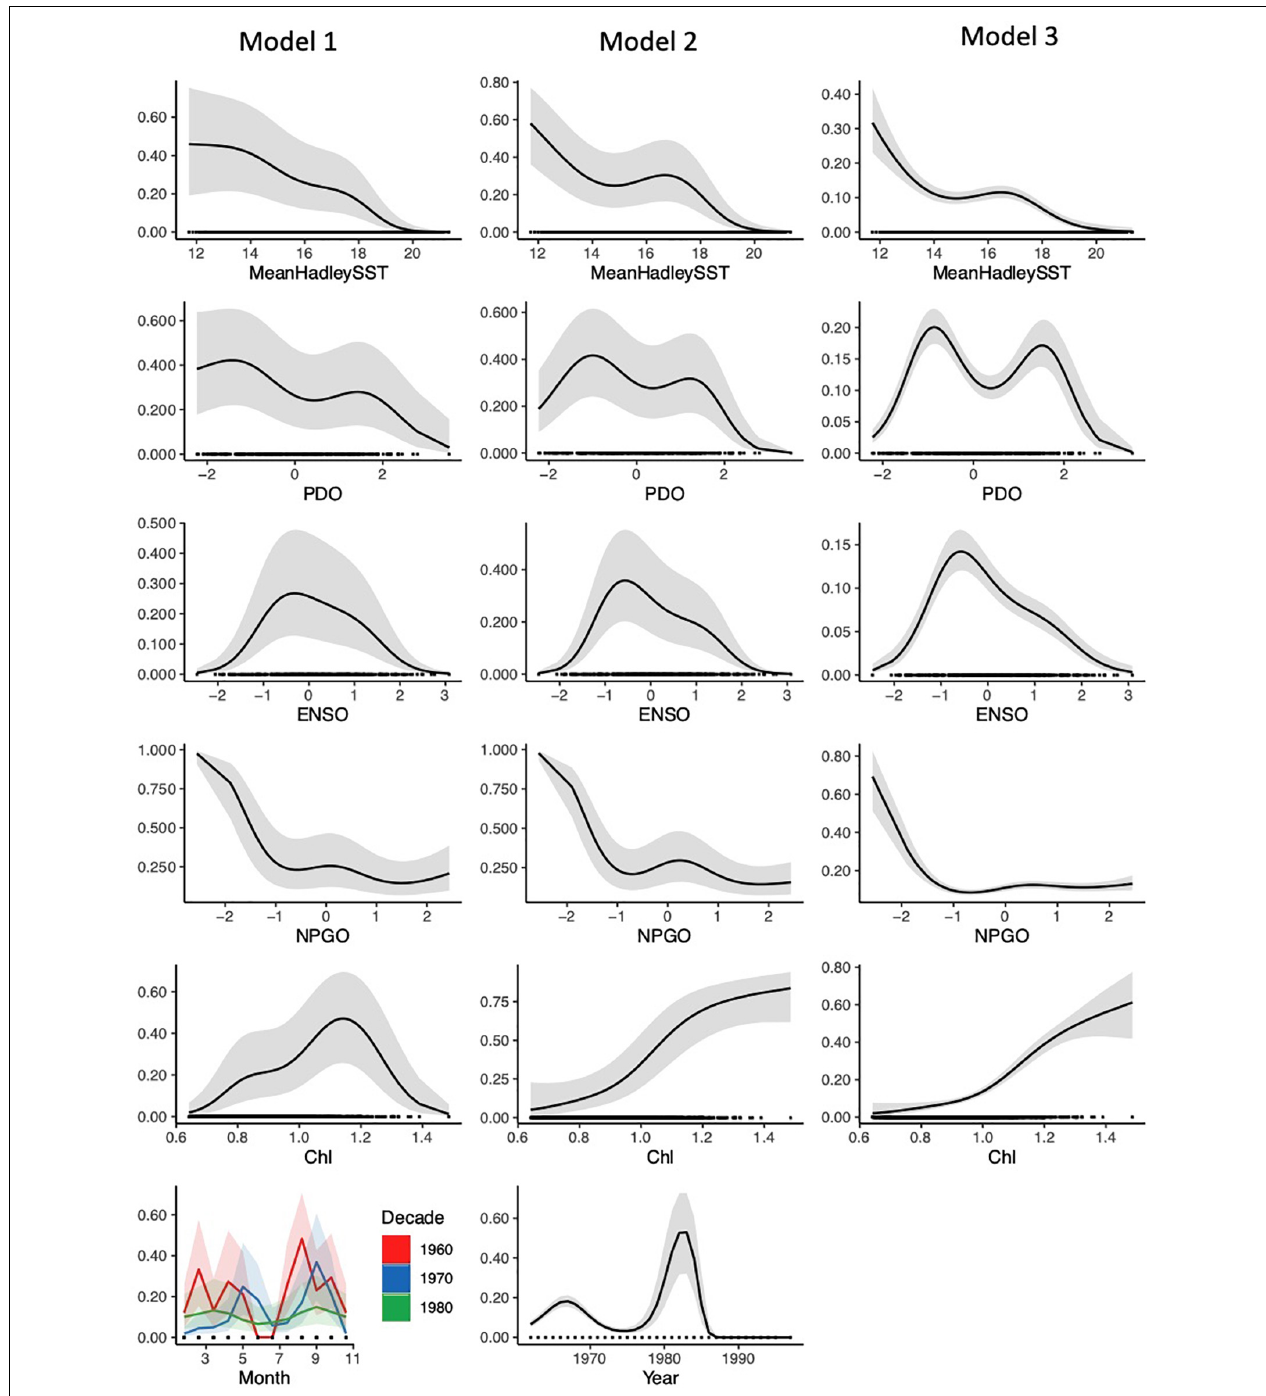
FIGURE 4 | Partial response plots for the temporal and environmental predictors from each of the three models, fitted to the systematic survey data (parameters for each model are fully outlined in Table 1 ). The y -axis represents predicted probabilities of basking shark sightings. There was little variation in each of the five iterations of model testing and training. This is a representative example of one